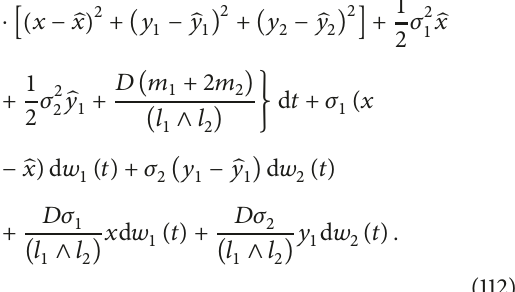
vital rates and other parameters which do not correspond to some specific biological populations and exhibit only the the- oretical properties of numerical solutions of the considered model. In the figures, the red lines, blue lines, and green lines represent the trajectories of populations 𝑥(𝑡) , 𝑦 1 (𝑡) , and 𝑦 2 (𝑡) , respectively. Here we give numerical simulations of model (6) with the same initial values 𝑥 0 = 1 , 𝑦 10 = 0.9 , and 𝑦 20 = 0.1